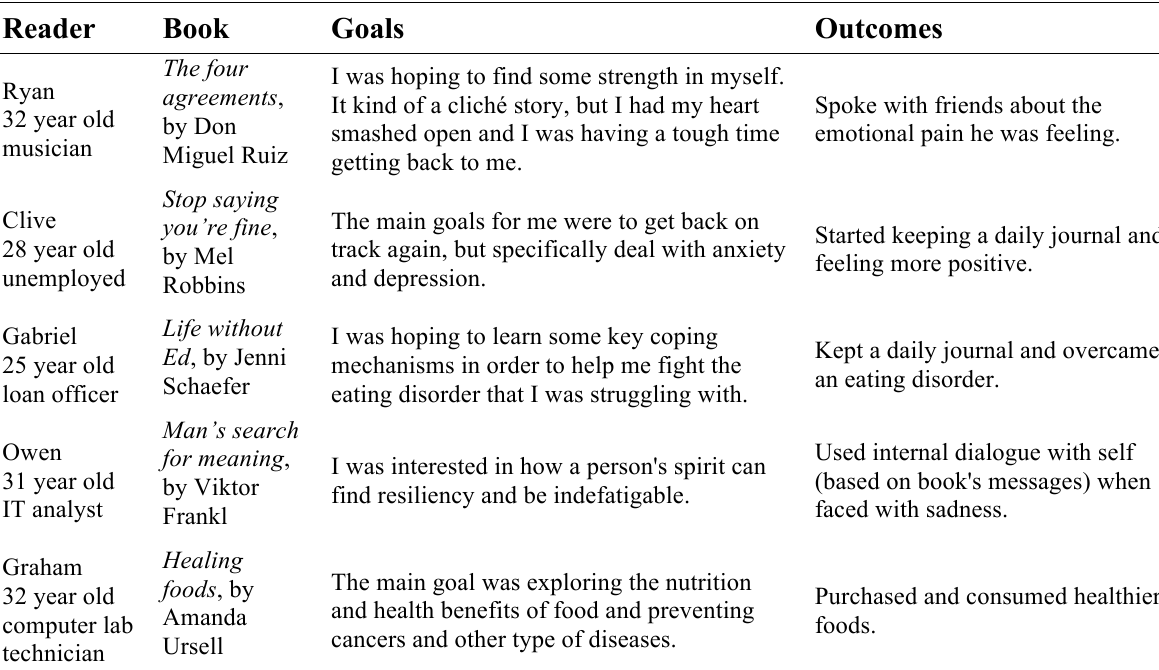
Table 5 : Male self-help reading and health